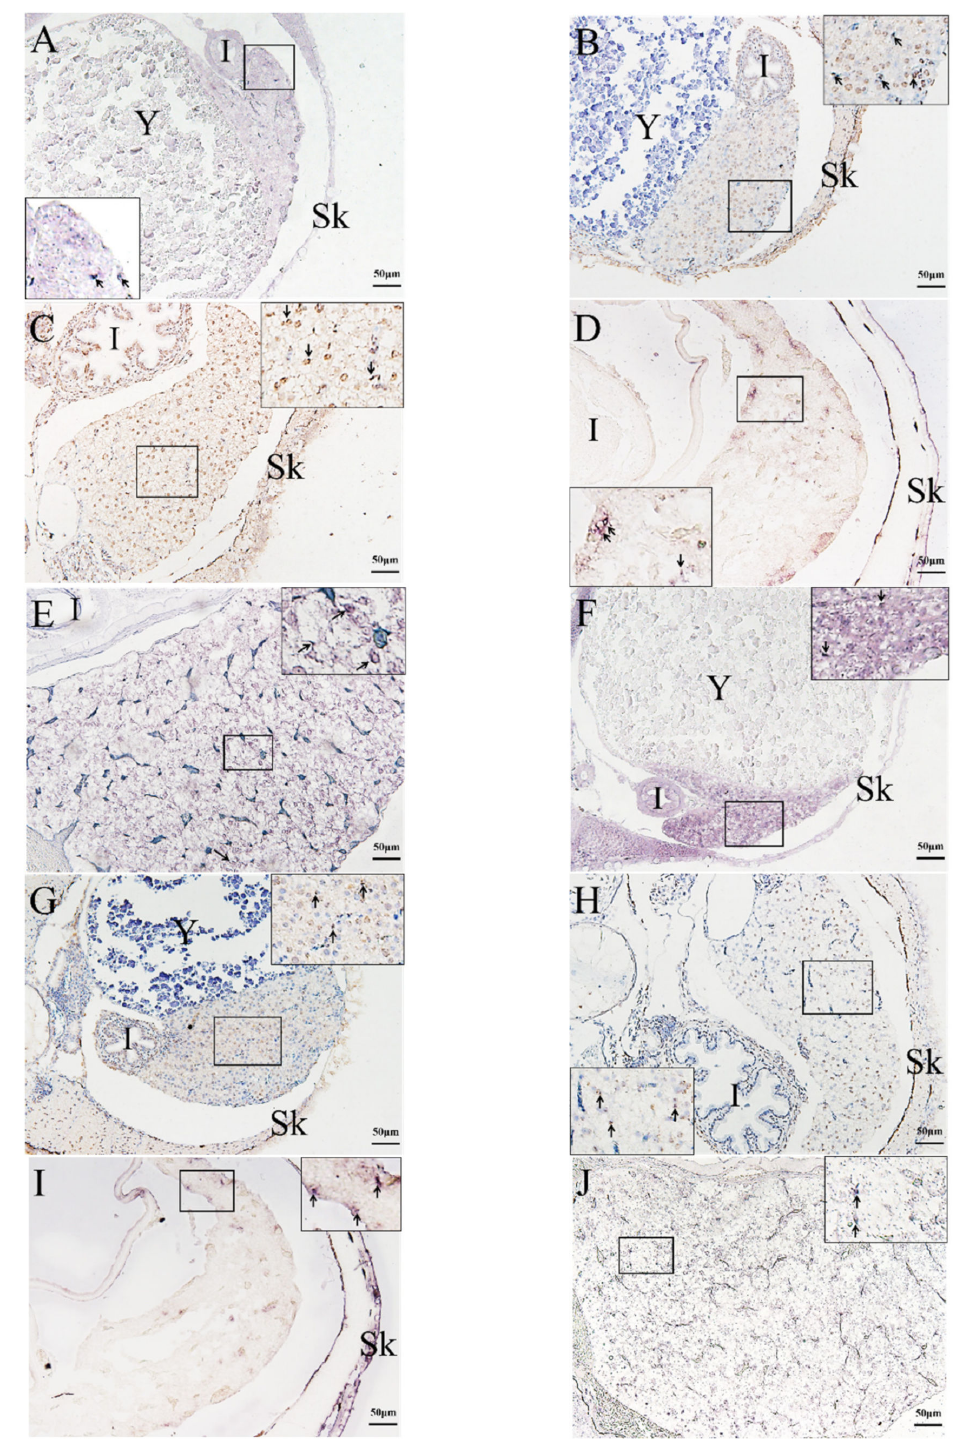
Figure 5. Expression of rags genes in the liver at different developmental stages. Rag1 ( A – E ) and rag2 ( F – J ) expression was randomly distributed in the entire liver. ( A , F ): 2 dph; ( B , G ): 6 dph; ( C , H ): 24 dph; ( D , I ): 30 dph; ( E , J ): 45 dph. ( B , C , G , H ): DAB staining, ( A , D – F , I , J ): NBT/BCIP staining. Bars: 50 µ m. Arrow: rags signal. Y: yolk. I: intestine. Sk: